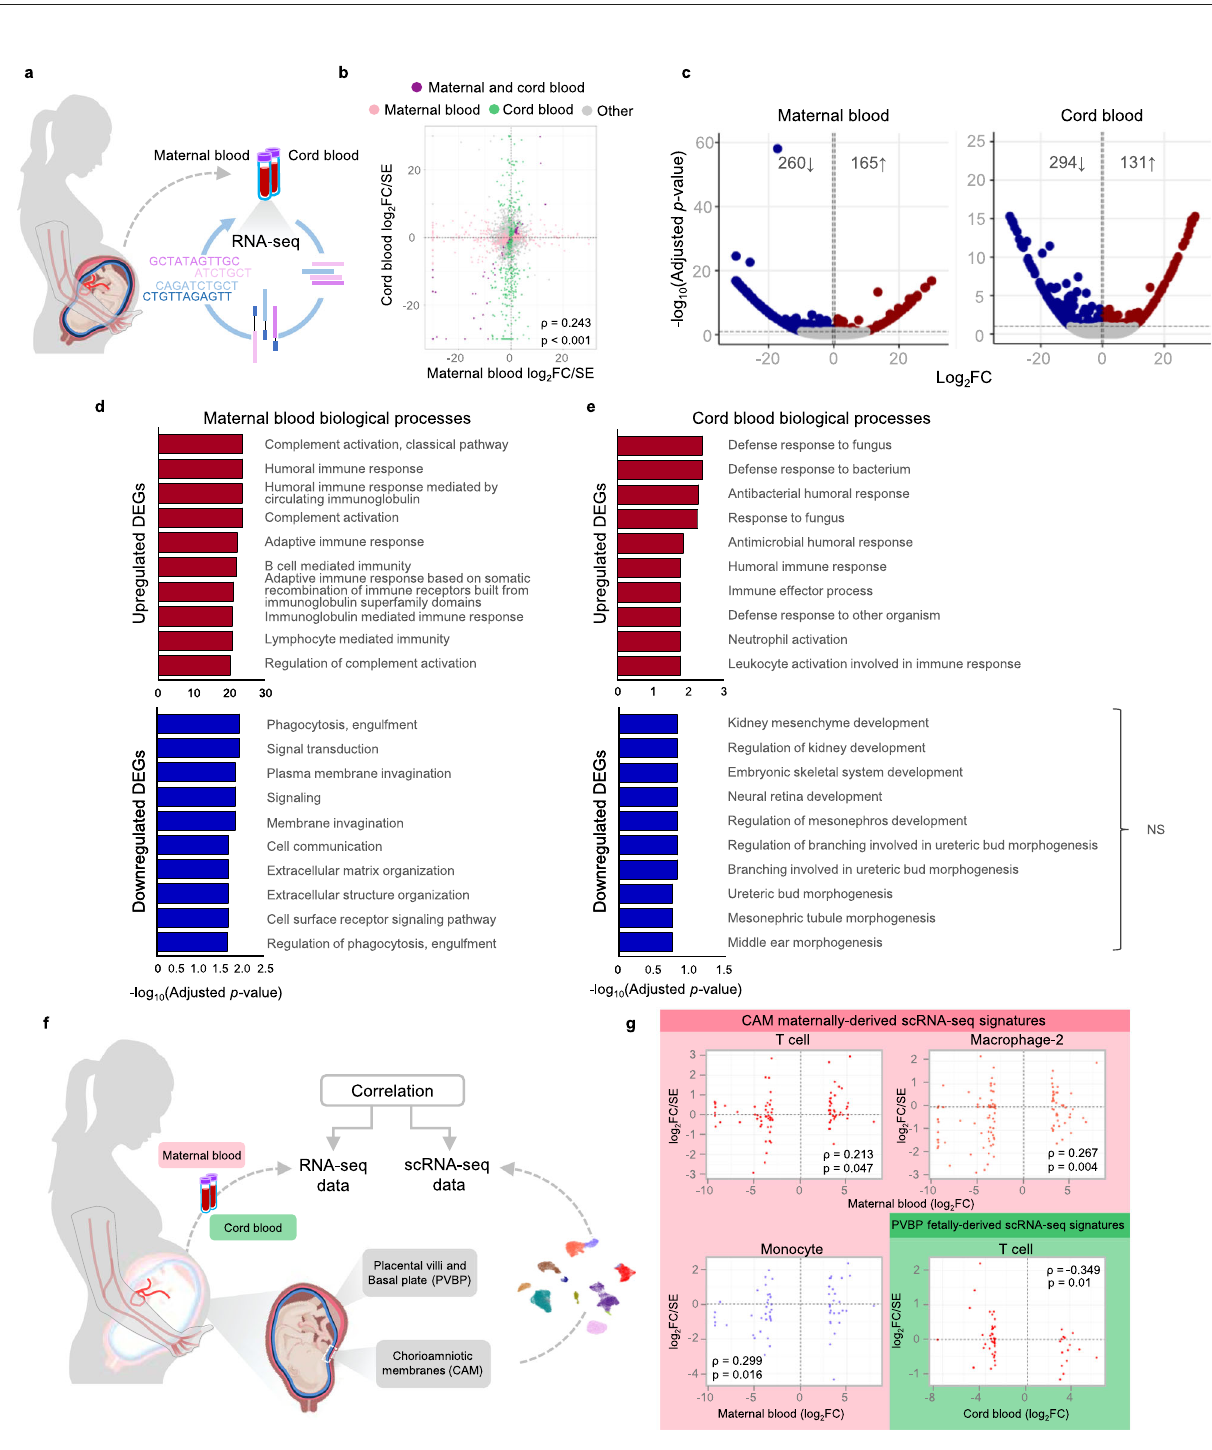
Fig. 5 Single-cell characterization of major cell clusters in the chorioamniotic membranes (CAM) and placental villi and basal plate (PVBP) of women with SARS-CoV-2 infection. a Scatter plots showing the effects of SARS-CoV-2 on gene expression [log 2 fold change (FC)] in maternal T cells from the CAM and PVBP compared to a previously reported dataset (Meckiff et al., 2020). Black dots represent genes with nominal p < 0.01 in this study, which were used to calculate Spearman ’ s correlation. b Forest plots showing the log 2 (FC) of differentially expressed genes (DEGs) associated with SARS-CoV-2 infection in Stromal-1, T cell, Macrophage-2, decidual, lymphoid endothelial decidual cell (LED), Monocyte, and extravillous trophoblast (EVT-1) cell types in the CAM and PVBP of SARS-CoV-2 ( + ) ( n = 9) or control women ( n = 10). DEGs shown are signi fi cant after false discovery rate (FDR) adjustment ( q < 0.1). c Violin plots showing the distribution of single-cell gene expression levels for the top six DEGs in the maternal T cell, maternal Macrophage-2, and fetal Stromal-1 cell types in the CAM comparing SARS-CoV-2 ( + ) and control women. d Kyoto Encyclopedia of Genes and Genomes (KEGG) pathways enriched for DEGs in the maternal (M) cell types (decidual, T cells, and Macrophage-2) and fetal (F) Stromal-1 cell type from the CAM based on the over-representation analysis. A one-sided Fisher ’ s exact test was used. KEGG pathways with q < 0.05